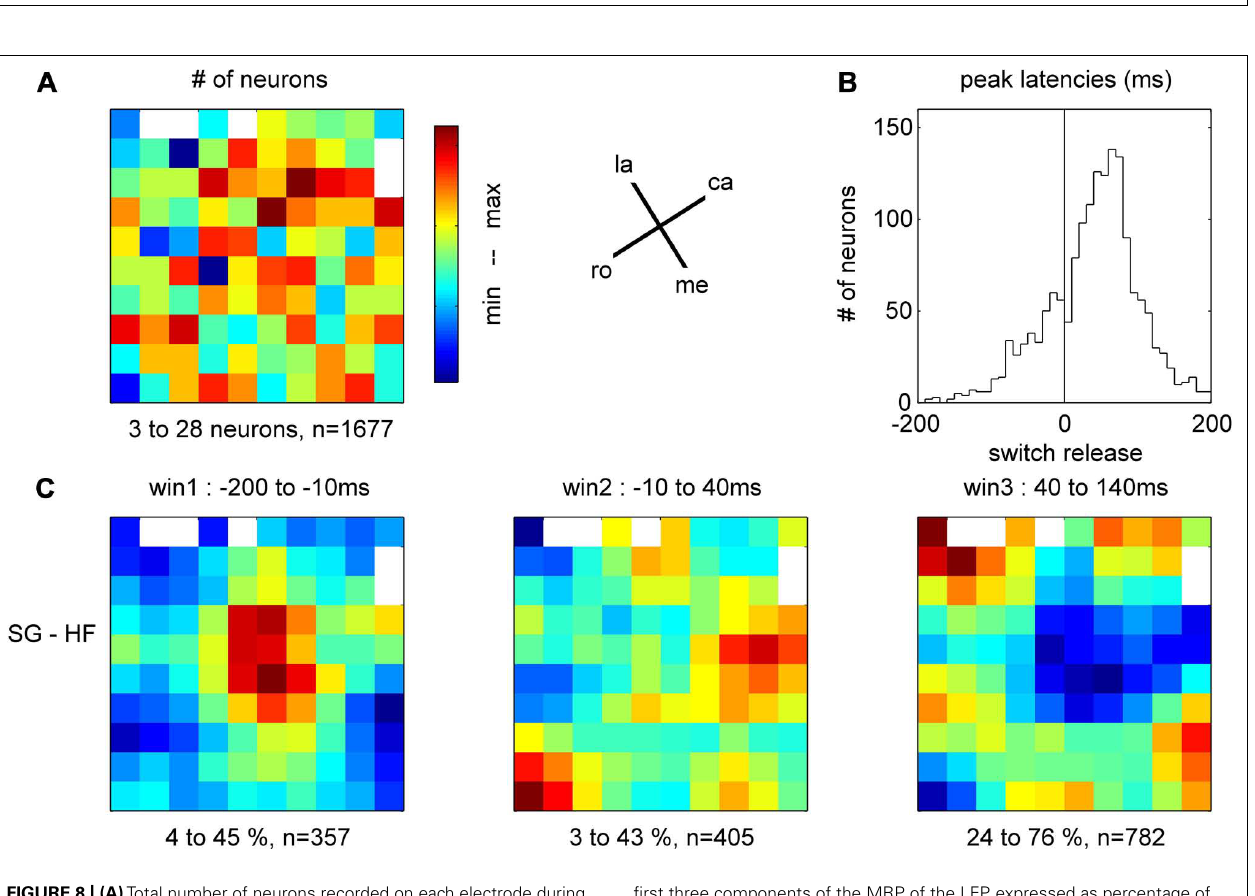
first three components of the MRP of the LFP, expressed as percentage of neurons from all neurons peaking around switch release ( ± 500 ms, n = 1677) on each electrode. For the color code, the min (blue)–max (red) values of the percentages are indicated below each map, as well as the total number of neurons peaking during the respective